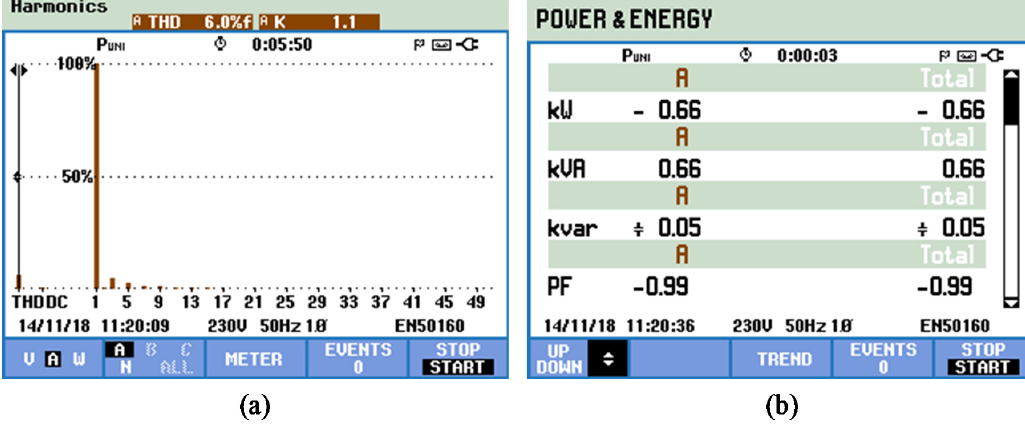
Figure 11. Experimental results during the MF-EVCS operation in V2G mode: ( a ) Harmonic spectrum of the ac-side current ( i evcs ); ( b ) Operating powers and total power factor.